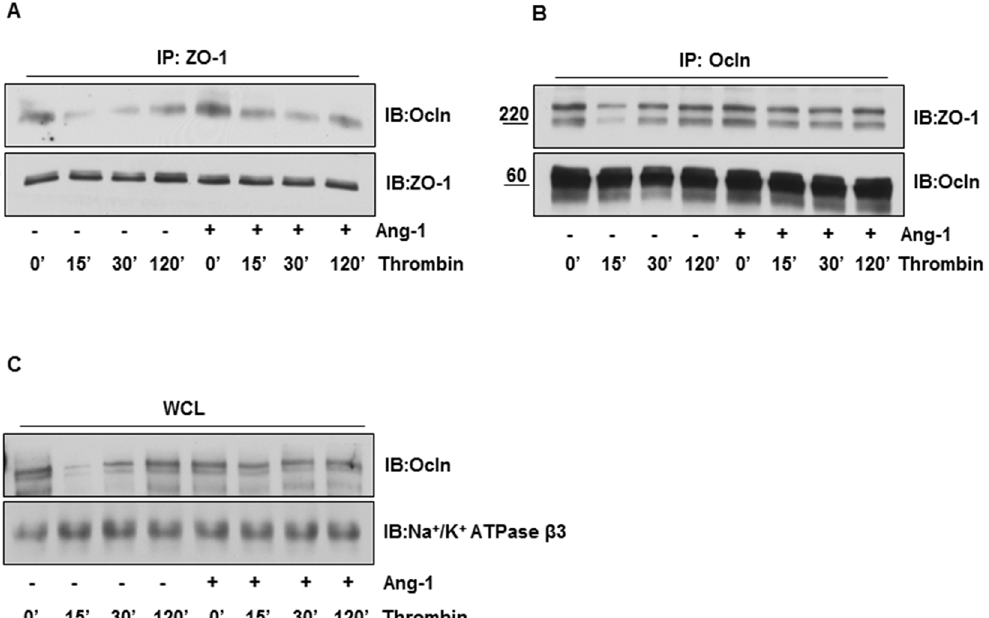
Fig 2. Ang-1 inhibits thrombin induced disassociation of Occludin with ZO-1 and its membrane dis-localization. Serum starved HBMECs were treated with 100nM thrombin alone or after Ang-1 (100ng/ml for 15 min) for indicated times. Cell lysates were immunoprecipitated with (A) anti-ZO-1 antibody and probed with anti-Occludin antibody, (B) anti-Occludin antibody and probed with anti-ZO-1 antibody. (C) After treating HBMECs with thrombin alone or pretreated with Ang-1 (100ng/ml for 15 min) followed by 100nM thrombin challenged for different times, plasma membrane fractions were prepared, separated on SDS gel and probed for Occludin. Na + -K + ATPase β 3 was used as a membrane